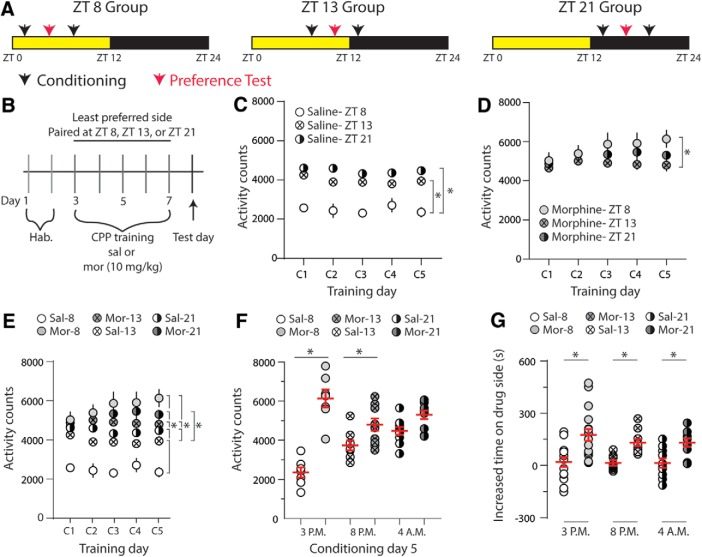
The time of day of morphine conditioning does not influence morphine-induced CPP. A, CPP experimental groups. B, Time line of CPP procedure. Mice were allowed to acclimate to the chambers for 2 d during habituation (Hab). During conditioning (days 3–7), mice were injected with saline (sal) or morphine (mor; 10 mg/kg, i.p.) and paired with the least preferred side at either ZT8, ZT13, or ZT21 CPP tests were performed 24 h postconditioning. C, Summary showing activity counts for saline-treated animals during conditioning days (C1–C5) at each time point measured (ZT8, ZT13, or ZT21) [saline (Sal)-ZT8: n = 7; saline (Sal)-ZT13: n = 8; saline (Sal)-ZT21: n = 10; F(8,88) = 0.766, p = 0.63; two-way repeated measures ANOVA with Bonferroni post hoc test]; *p < 0.05. D, Summary showing activity counts for morphine-treated animals during conditioning days (C1–C5) at each time point measured (ZT8, ZT13, or ZT21; morphine (Mor)-ZT8: n = 7; morphine (Mor)-ZT13: n = 10; morphine (Mor)-ZT21: n = 10; F(8,96) = 1.48, p = 0.17; two-way repeated measures ANOVA with Bonferroni post hoc test]; *p < 0.05. E, Summary showing activity counts for saline (Sal)-treated or morphine (Mor)-treated animals during conditioning days (C1–C5) at each time point measured (ZT8, ZT13, or ZT21); [saline (Sal)-ZT8: n = 7; morphine (Mor)-ZT8: n = 7; saline (Sal)-ZT13: n = 8; morphine (Mor)-ZT13: n = 10; saline (Sal)-ZT21: n = 10; morphine (Mor)-ZT21: n = 10; F(20,184) = 2.08, p = 0.006, two-way repeated measures ANOVA with Bonferroni post hoc test]; *p < 0.05. F, Summary showing activity counts for saline (Sal)-treated or morphine (Mor)-treated animals mice on conditioning day 5 at each time point measured [saline (Sal)-ZT8: n = 7; morphine (Mor)-ZT8: n = 7; saline (Sal)-ZT13: n = 8; morphine (Mor)-ZT13: n = 10; saline (Sal)-ZT21: n = 10; morphine (Mor)-ZT21: n = 10; F(5,46) = 17.6, p < 0.0001, one-way ANOVA with Bonferroni post hoc test]; *p < 0.05. G, Summary showing that the time of day of morphine conditioning does not influence morphine-induced CPP [saline (Sal)-ZT8: n = 14; morphine (Mor)-ZT8: n = 17; saline (Sal)-ZT13: n = 8; morphine (Mor)-ZT13: n = 10; saline (Sal)-ZT21: n = 10; morphine (Mor)-ZT21: n = 10; F(2,63) = 0.267, p = 0.767; two-way ANOVA with Bonferroni post hoc test]; *p < 0.05.